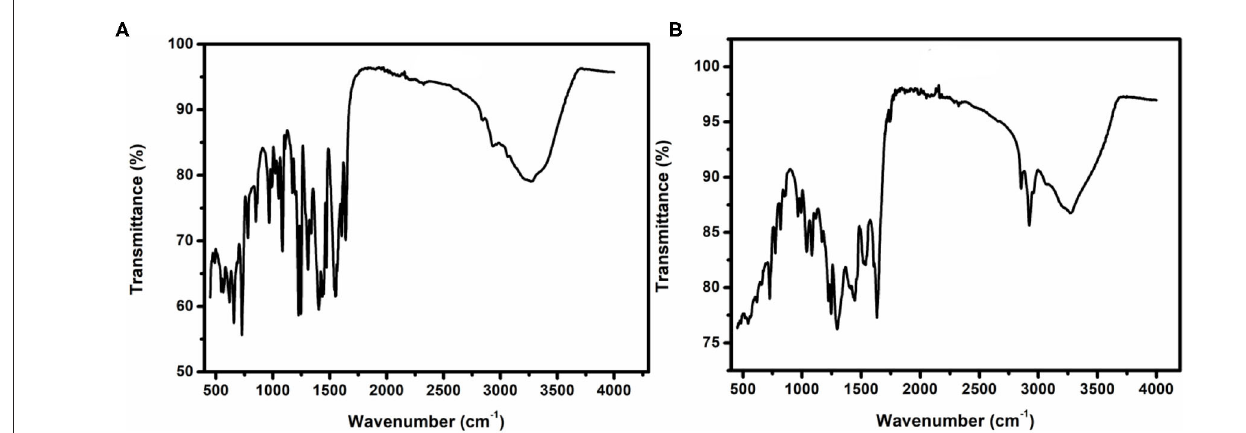
FIGURE 5 | FT-IR of (A) complex 1 and (B) complex 2.